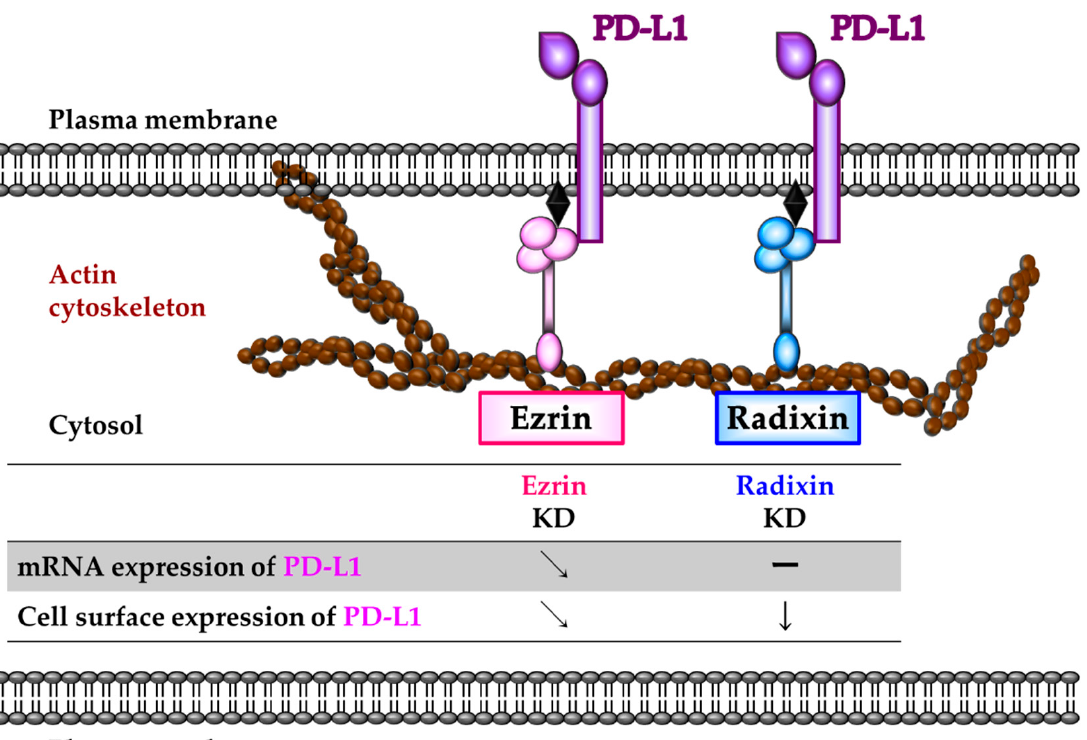
Figure 7. Schematic representation illustrating the role of ezrin and radixin protein in the regulatory mechanism of programmed death ligand-1 (PD-L1) expression in KP-2 cells. Ezrin may modulate the transcriptional and/or post-translational process of PD-L1. Radixin may contribute to the plasma membrane localization of PD-L1 to a greater extent than did ezrin, possibly through the protein– protein interaction, with little influences on the mRNA levels of PD-L1 in KP-2 cells. Therefore, radixin may function as essential scaffold protein primarily responsible for the cell surface localization of PD-L1 in KP-2 cells.